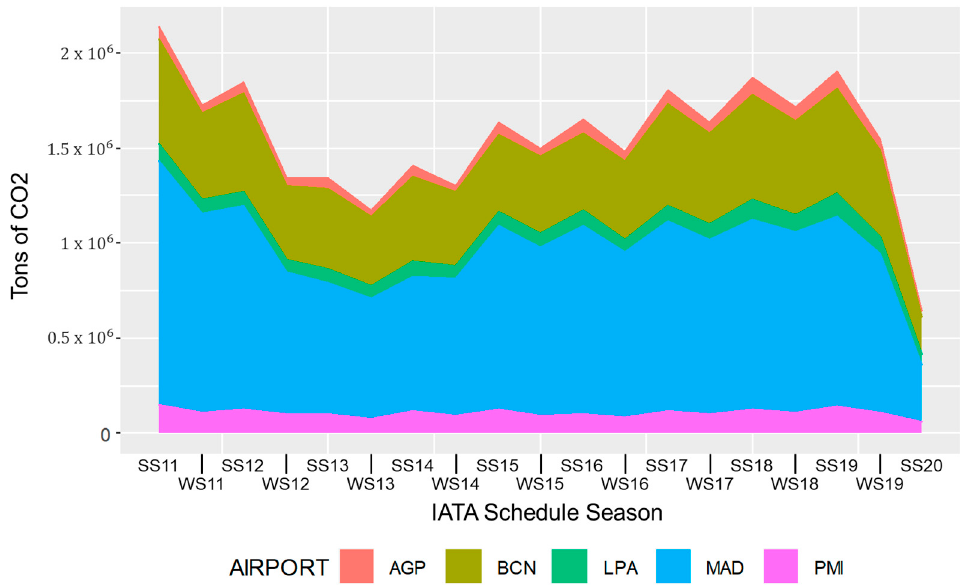
Figure 5. Cumulative carbon dioxide emissions in tons (T) of carbon dioxide equivalent associated with scheduled seasons between 2001 and 2020. Source: own calculation based on data published by [19] according to guidelines provided by [20]. Note: although the IATA Summer schedule begins on the last Sunday of March and ends on the last Saturday of October, and the IATA Winter schedule begins on the last Sunday of October and ends on the last Saturday of March, the calculation has been made by considering the same semester period in every year for simplification purposes.